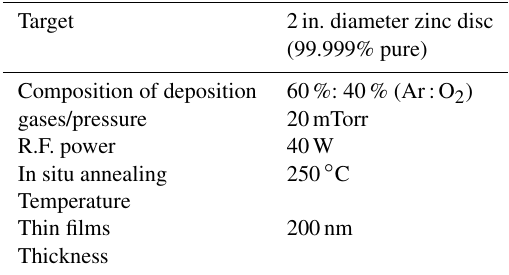
Table 1. Physical parameter for the growth of the ZnO thin film. Growth using R.F. magnetron sputtering.